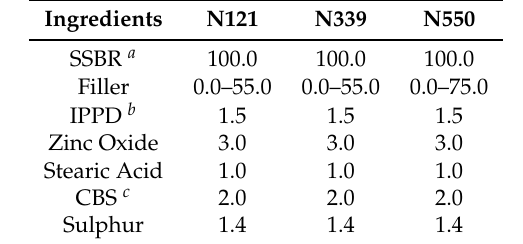
Ingredients Reinforcing Resin IR d 100.0 N339 20.0–60.0 Resorcinol 0.0/0.7/4.6 HMMM e 0.0/0.7/4.6 6PPD f 2.0 TMQ g 1.0 Zinc Oxide 6.0 Stearic Acid 1.0 Processing Oil 3.0 DCBS h 1.0